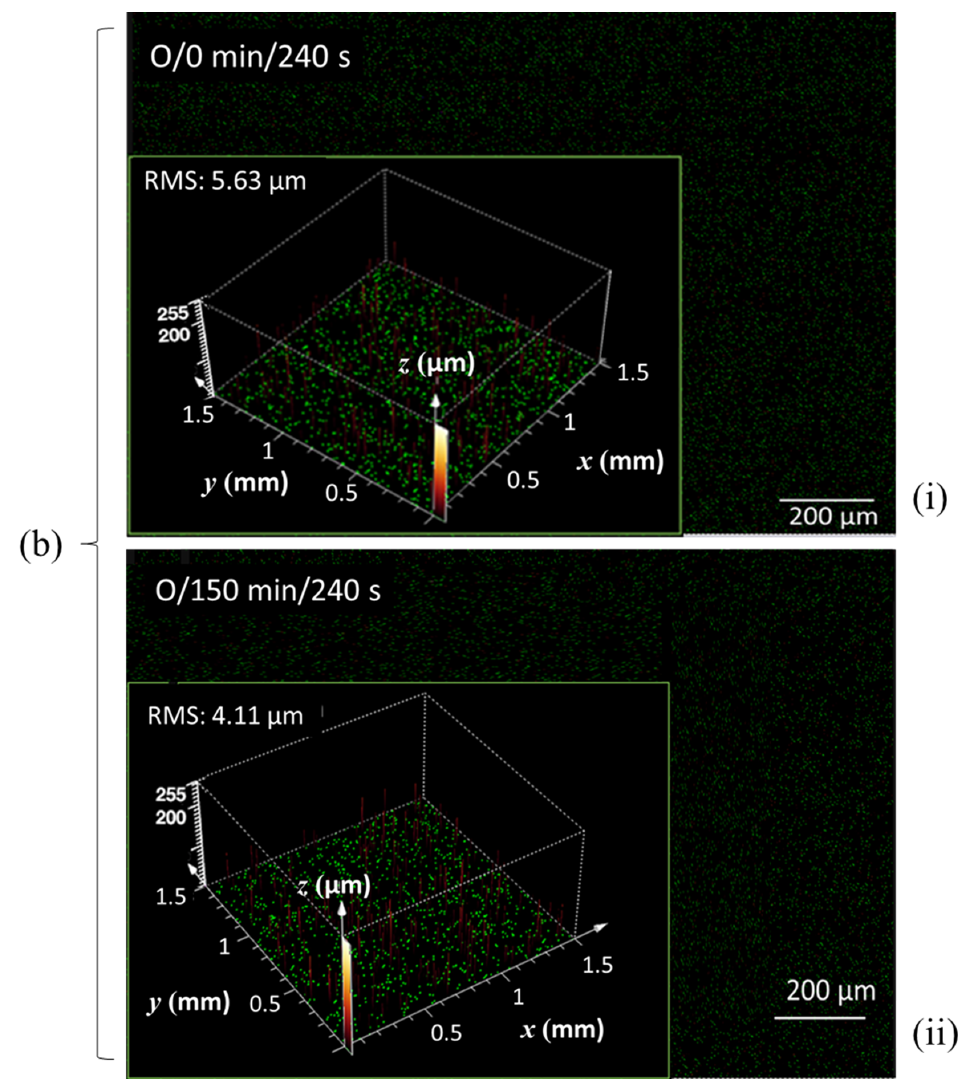
Figure 10. CLSM surface profile plots, showing the microscan as background and contour height spatial distribution in the insert, comparing the effect of enzymatic pretreatment at ( a ) constant O plasma exposure of 120 s ( i ) 60 min, ( ii ) 150 min, and ( iii ) 300 min under enzymatic pretreatment, respectively, and ( b ) comparing ( i ) zero versus ( ii ) 150 min enzymatic pretreatment, both at the longer O plasma exposure time of 240 s. Table 3. RMS microroughness values from CLSM scans of selected plasma-exposed MNFC films, showing the impact of N and O plasma exposure, respectively. Selection was based on samples showing the greatest property differences between ing this display technique.